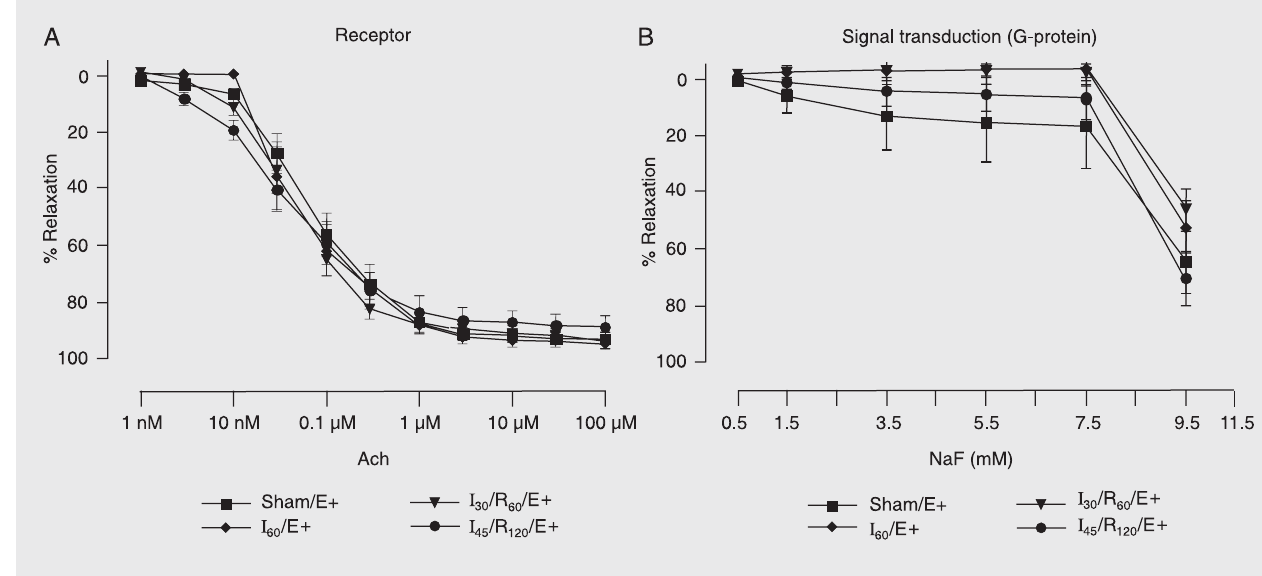
Figure 2. Concentration-response curves to acetylcholine (Ach, A) and sodium fluoride (NaF, B) by the hepatic artery endothelial membrane. Hepatic artery segments were exposed to sham operation (Sham), 60 min of ischemia (I 60 ), 30 min of ischemia followed by 60 min of reperfusion (I 30 /R 60 ), and 45 min of ischemia followed by 120 min of reperfusion (I 45 /R 120 ) with endothelium (E+). Data are reported as means ± SEM, N = 6 per group. Arterial segments were first contracted with prostaglandin F 2 α and exposed to increasing drug concentrations. No significant difference was found among groups